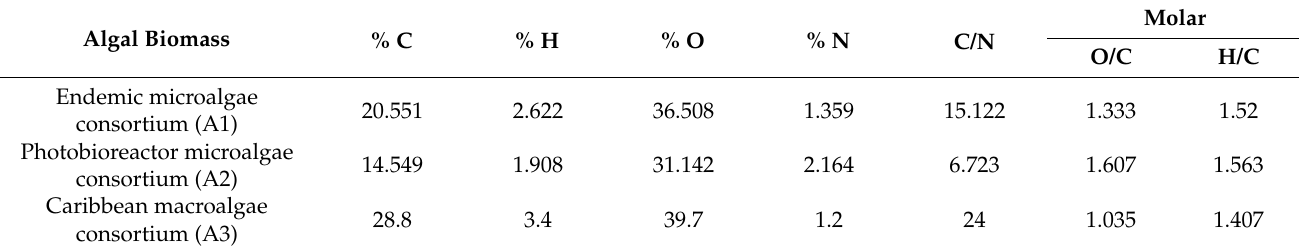
Table 1. Ultimate analysis of biomasses by elemental